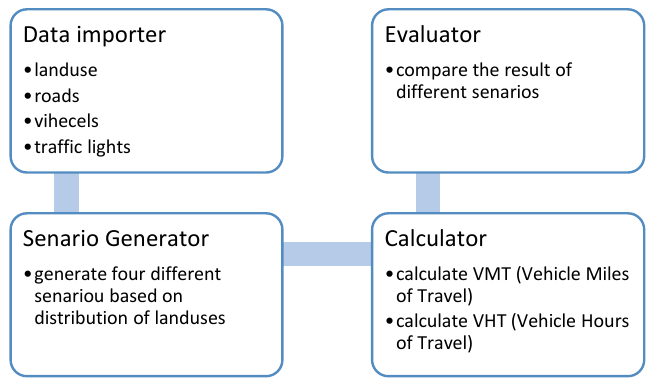
Fig. 5. Flowchart of the proposed